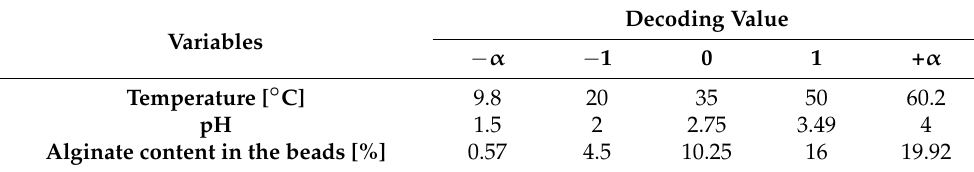
Table 3. Decoding values of independent variables used in the experimental design.